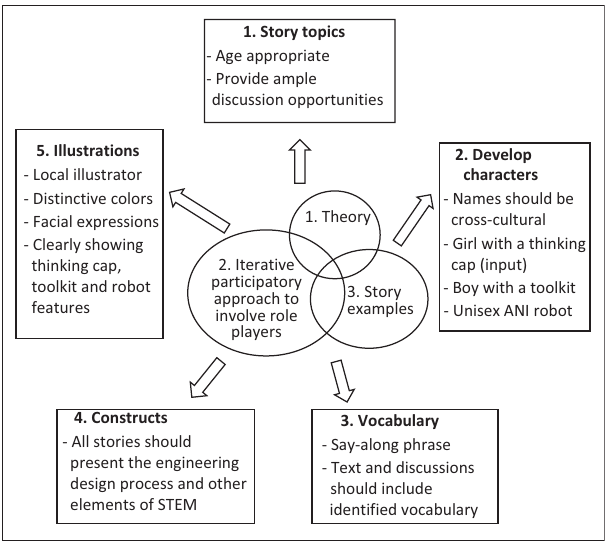
FIGURE 2: Conceptual framework as bedrock for a dialogic reading programme